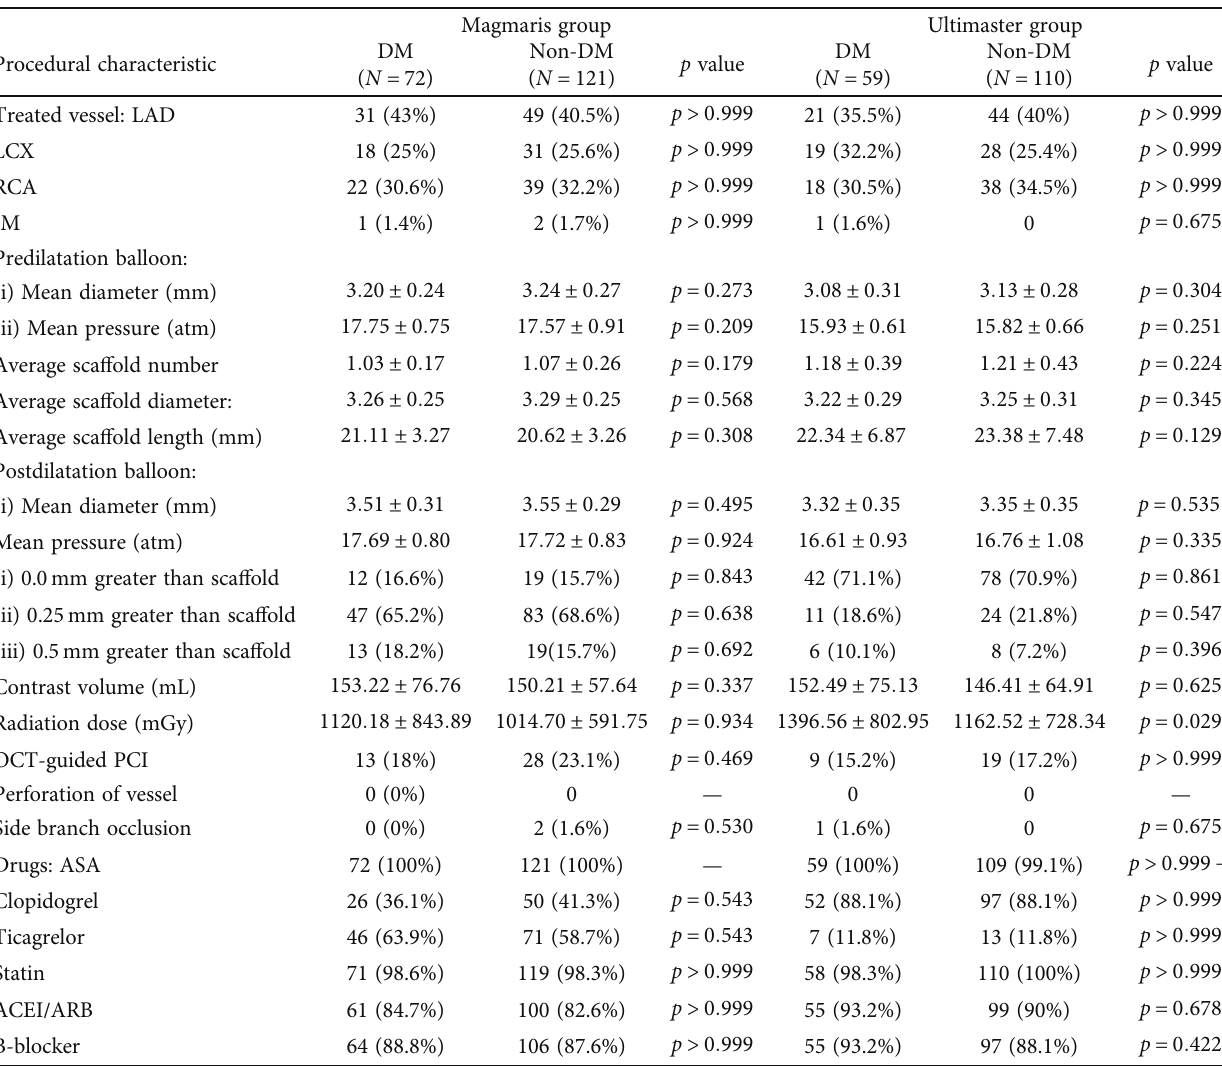
Table 2: Procedural characteristics of both study arms. Magmaris